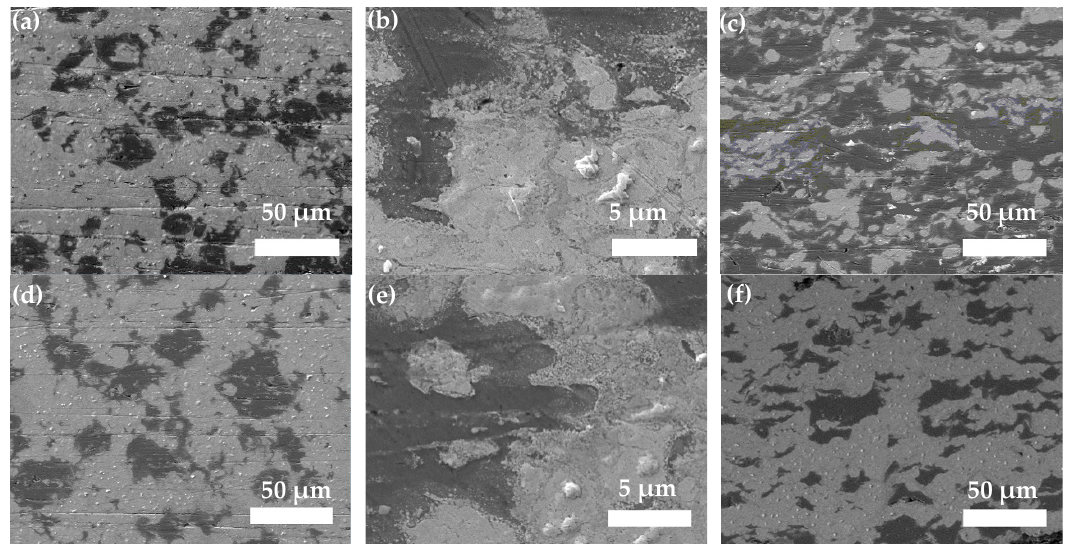
Figure 3. Microstructure of the surface of two composite coatings: ( a ) the surface of the